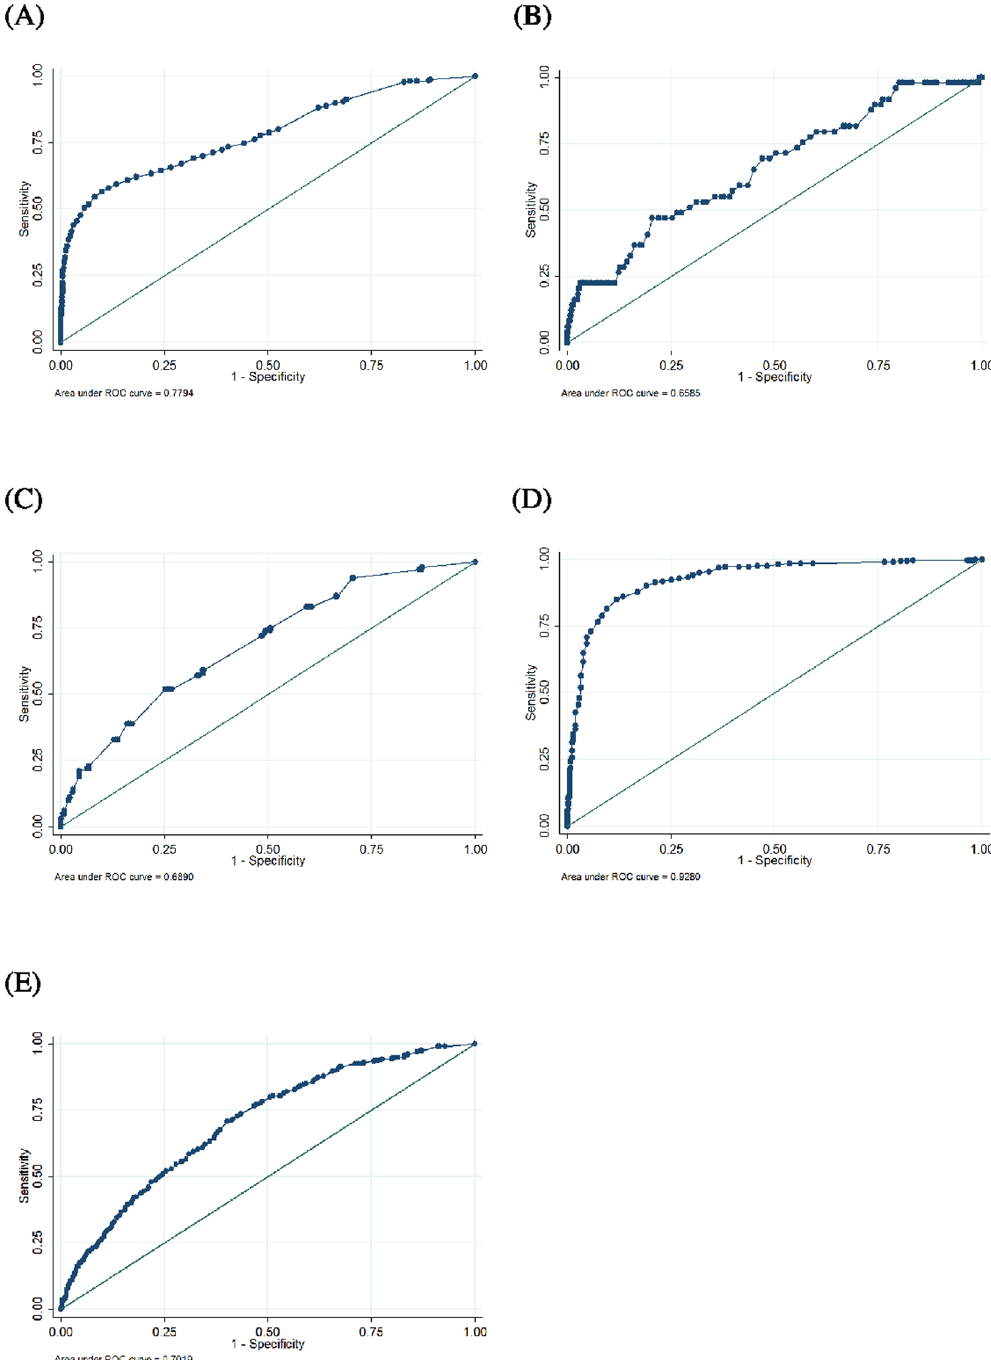
Figure 2. The receiver operating characteristic (ROC) curve of using ( A ) the voiding detrusor pressure at maximum flow rate (Pdet.Qmax) to predict bladder outlet obstruction, ( B ) the Abrams-Griffiths number to predict anatomic bladder outlet obstruction, ( C ) the post-void residual to predict bladder neck dysfunction, ( D ) the Pdet.Qmax to predict dysfunctional voiding, and ( E ) the bladder contractility index to predict bladder